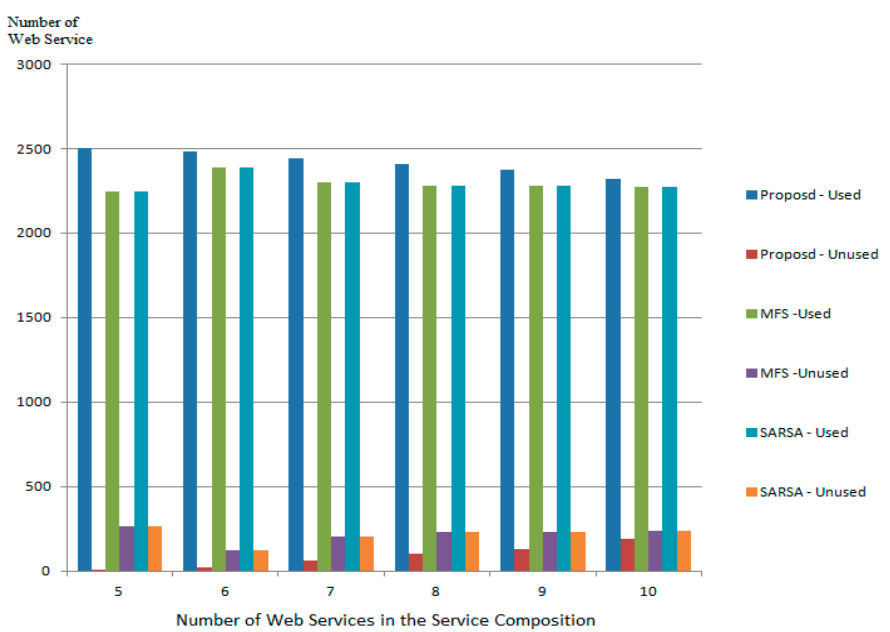
Figure 6. Number of constructed service compositions when the composition threshold = 200.